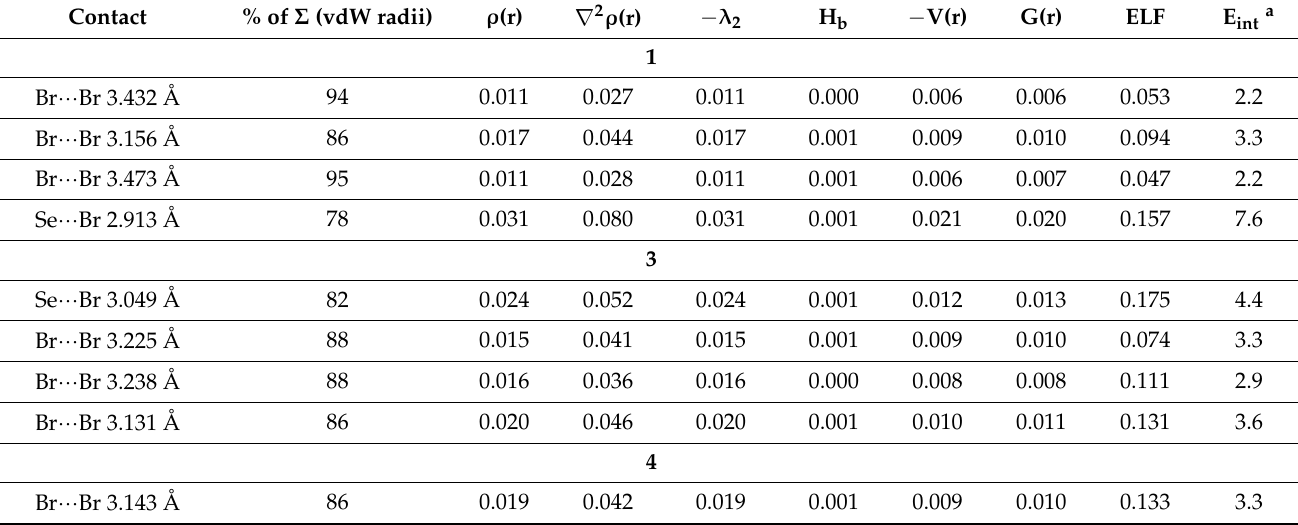
Table 1. Values of the density of all electrons ρ ( r ), Laplacian of electron density ∇ 2 ρ ( r ) and appropriate λ 2 eigenvalues, energy density H b , potential energy density V( r ), and Lagrangian kinetic energy G( r ), electron localization function ELF (a.u.) at the bond critical points (3, –1) for intermolecular interactions in 1 , 3 , 4 , and their estimated strength E int